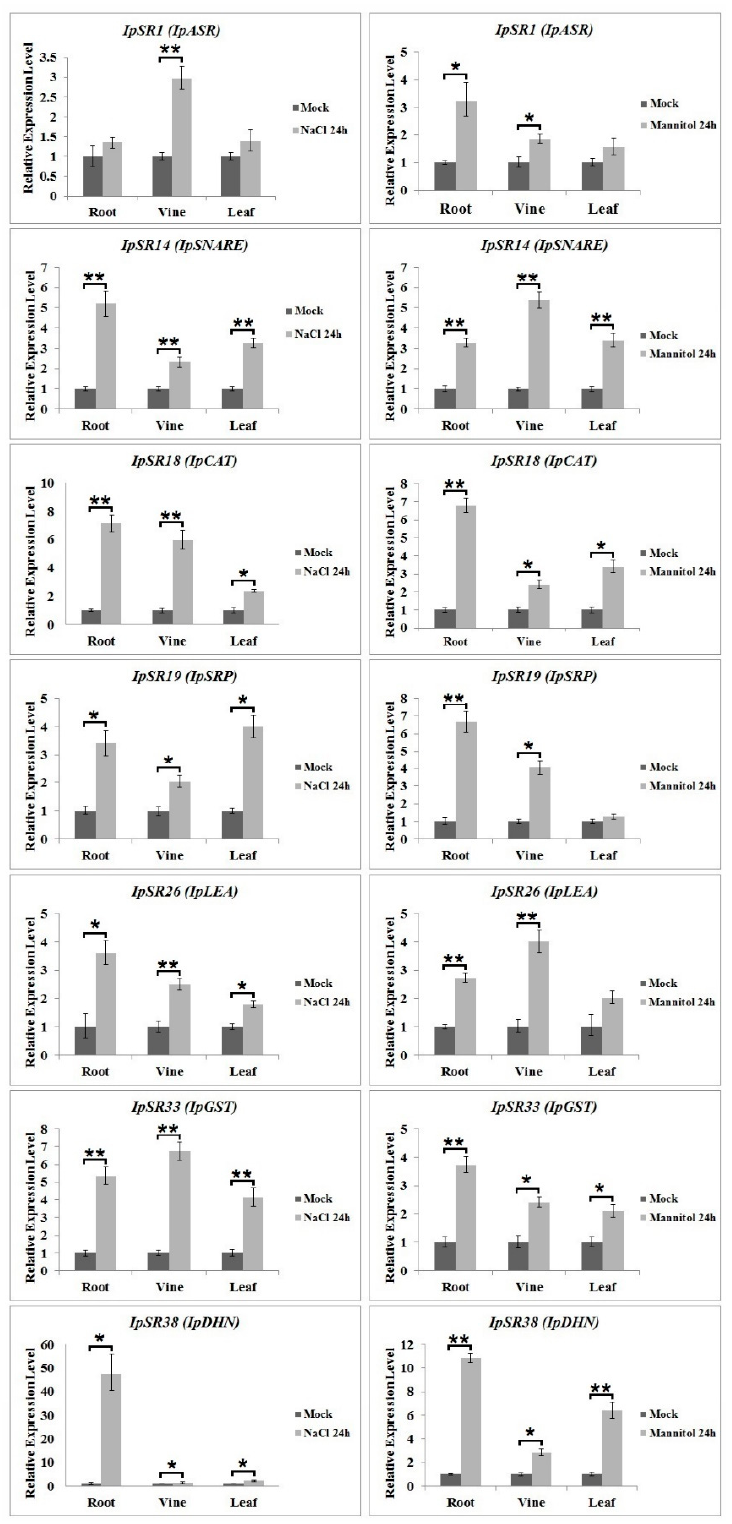
Figure 6. RT-PCR analyses of seven salinity-tolerant candidate genes ( IpSR1 , IpSR14 , IpSR18 , IpSR19 , IpSR26 , IpSR33 , and IpSR38 ) in the roots, vines, and leaves of I. pes-caprae seedlings under salinity (left, 300 mM NaCl) and osmotic (right, 300 mM mannitol) stresses at 0 and 24 h. The house-keeping gene IpUBQ (GenBank accession number: MF502417) was used as a reference gene. All determinations were carried out for three biological replicates. The results shown are the mean ± SD ( n ≥ 3). * and ** indicate significant differences in comparison with the wild type at 0.01 < p < 0.05 and p < 0.01, respectively (Student’s t -test).